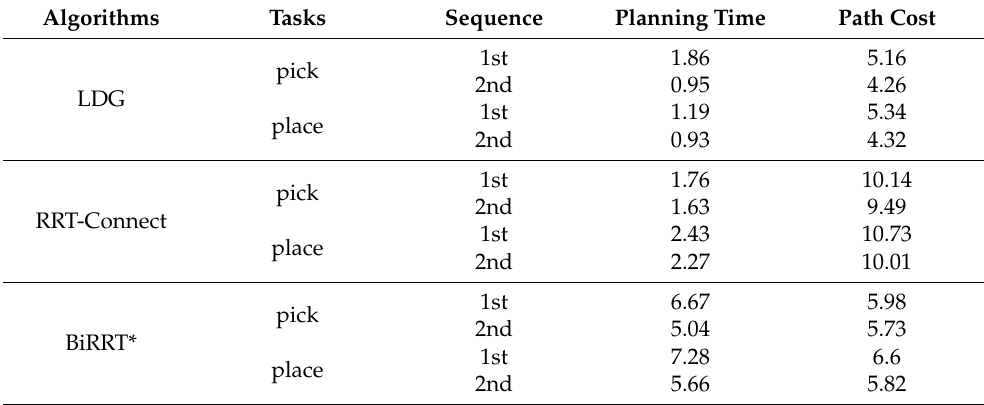
Table 3. Numerical results of AUBO − i5 repetitive motion planning in shelf stacking task.